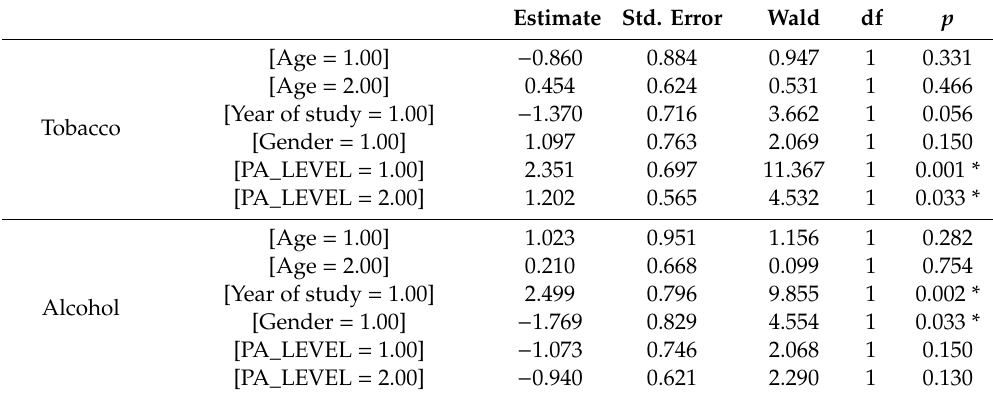
Table 4. Parameter estimates of tobacco and alcohol